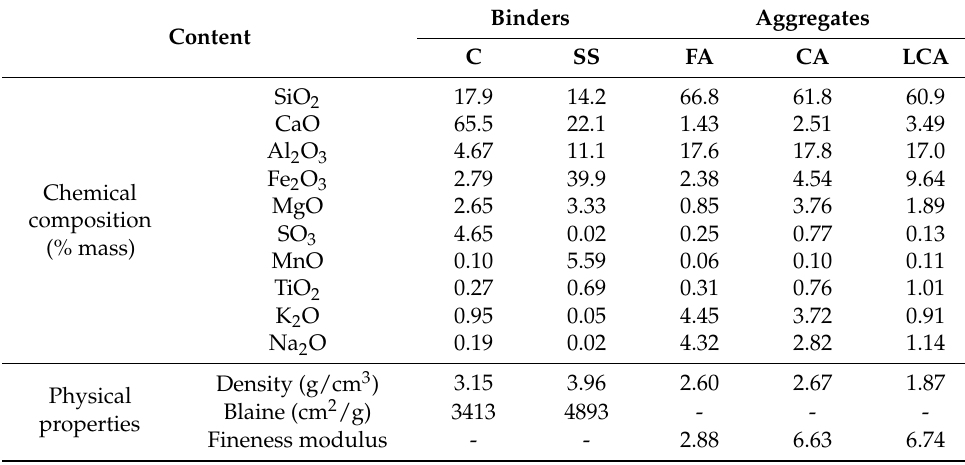
Table 2. Chemical compositions and physical properties of binders and aggregates.